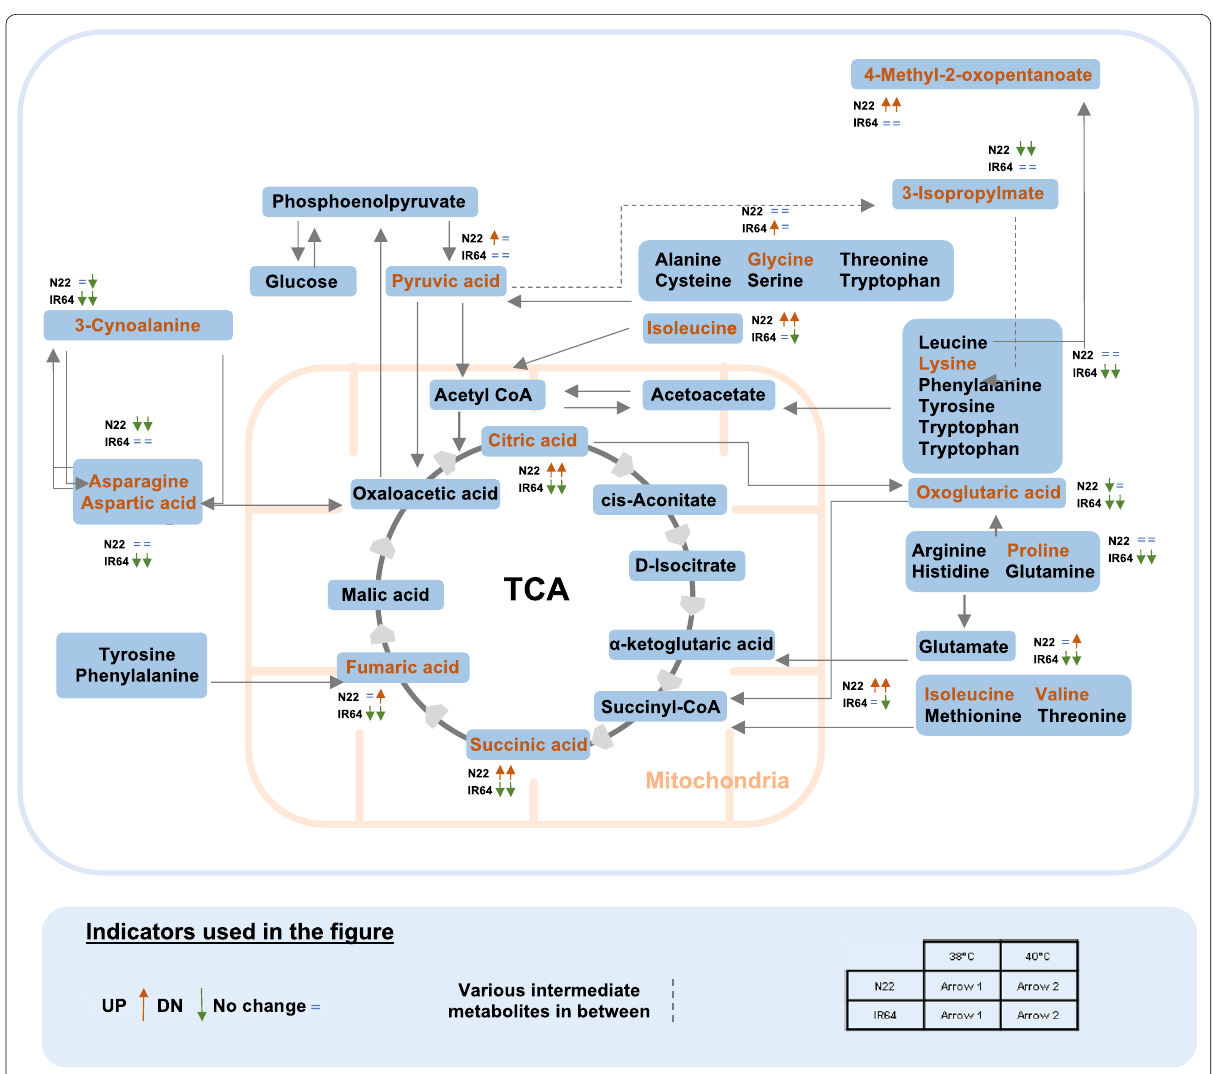
Fig. 10 Schematic diagram showing differential abundant metabolites detected in first five highly altered metabolic pathways (including TCA cycle and amino acid pathways) in the two rice genotypes (N22 and IR64) exposed to control and two high temperature treatments (38 °C and 40 °C) for six days during gametogenesis. Up and down arrows indicate regulation based on fold change, while only those metabolites that changed significantly at 5% LSD were included. DN –